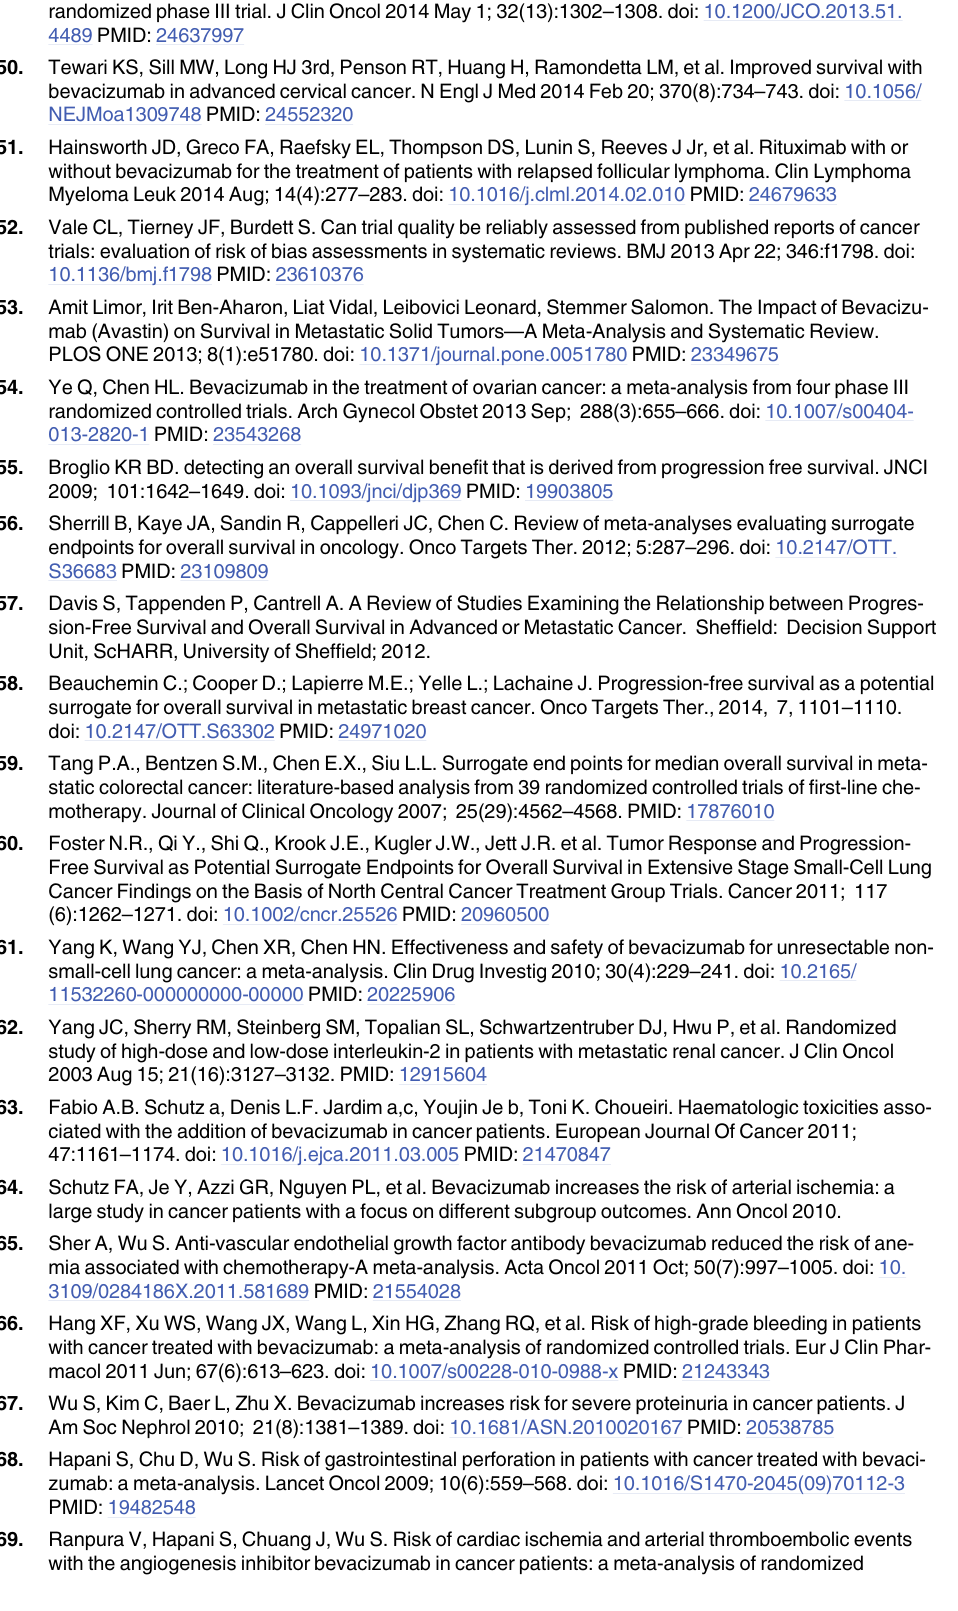
PLOS ONE | DOI:10.1371/journal.pone.0136324 September 2,